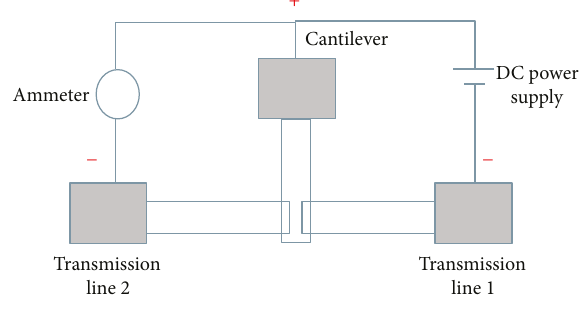
Figure 9: Circuit con fi guration for DC